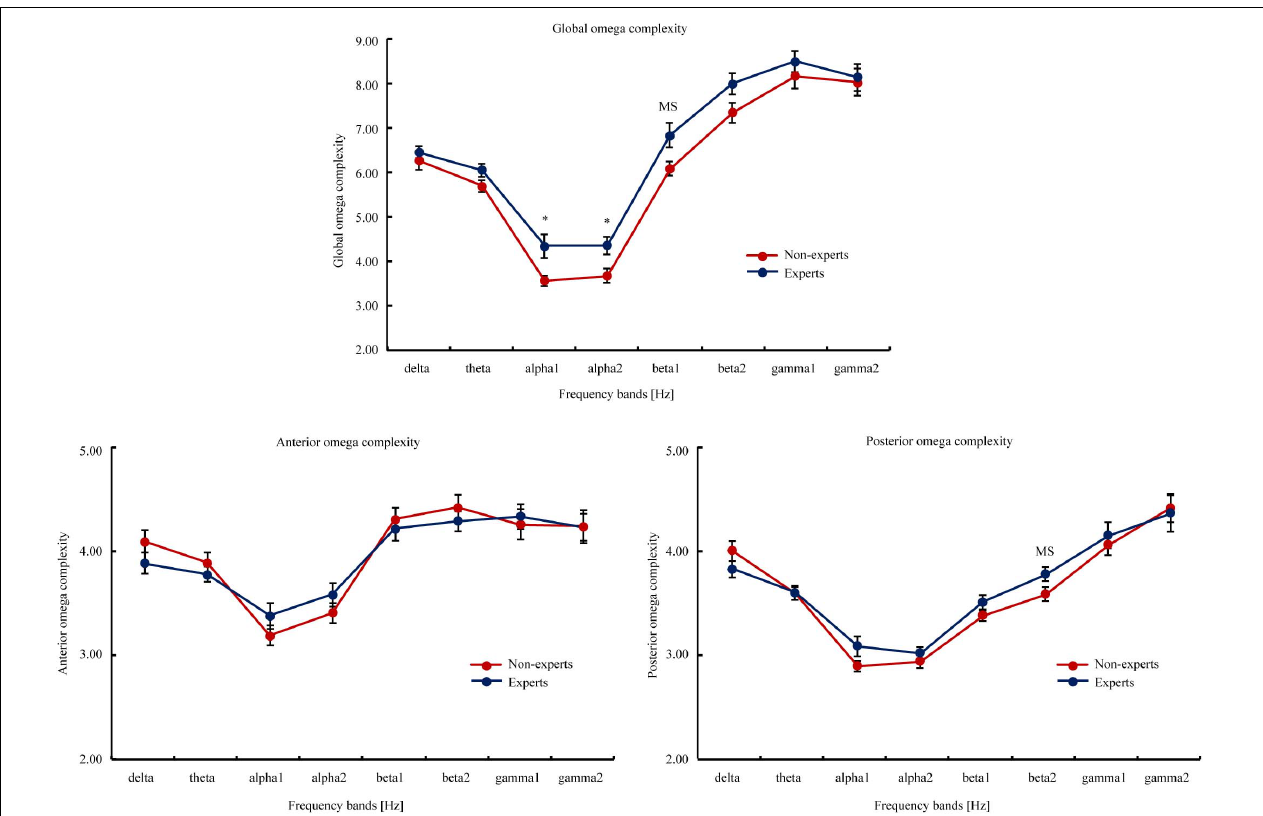
FIGURE 4 | The global, anterior, and posterior omega complexity of the eight EEG frequency bands (i.e., delta, theta, alpha1, alpha2, beta1, beta2, gamma1, and gamma2) in the PUBG non-experts and experts. The global omega complexity involved all scalp electrodes; the anterior omega complexity involved FP1, FP2, FT9, FT10, F3, F4, F7, and F8; the posterior omega complexity involved P7, P3, PZ, P4, P8, O1, OZ, and O2. The eight frequency bands involved delta (2–4 Hz), theta (4–8 Hz), alpha1 (8–10.5 Hz), alpha2 (10.5–13 Hz), beta1 (13–20 Hz), beta2 (20–30 Hz), gamma1 (30–40 Hz), and gamma2 (40–60 Hz). Attain values from the interval 1 to m, the lowest value (i.e., 1) means the data is consisted of exactly one principal component or spatial mode, and a maximum synchronization between EEG signals at different scalp locations. The highest value (i.e., m) indicates the total data variance is uniformly distributed across all m principal component, and a maximum spatial complexity is observed. The upper bound on the maximum value is equal to the number of electrodes involved in the calculation. Error bars represent mean ± S.E.M. MS indicated marginal significance after FDR correction, * p [ FDR ] <